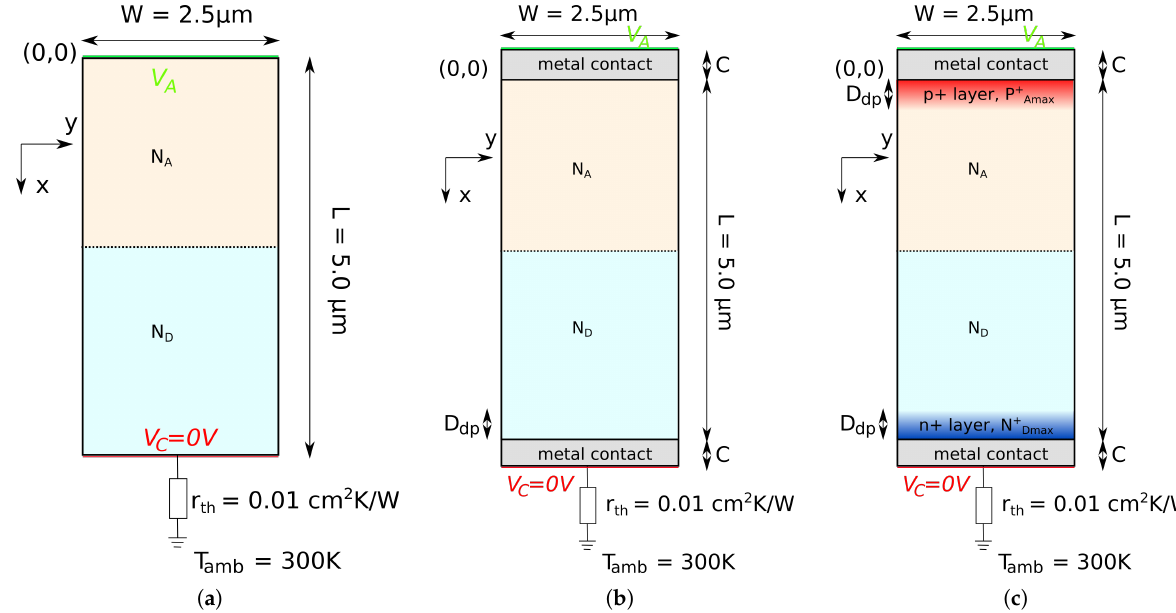
Figure 1. Different structures that can be used to model p–n junction. ( a ) Structure S0, default ohmic boundary condition. ( b ) Structure S1, metal contact. ( c ) Structure S2, metal-highly doped regions close to the contacts, C = 0.5 µ m, D dp = 0.5 µ